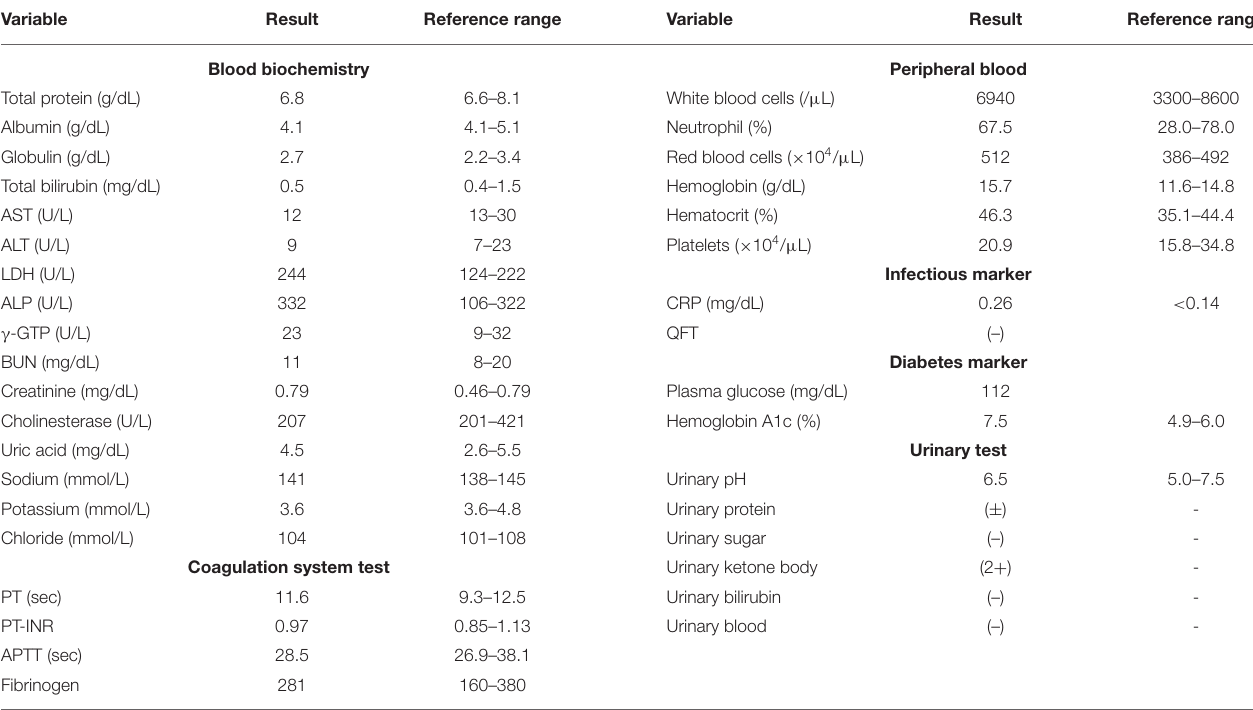
TABLE 1 | Laboratory data on